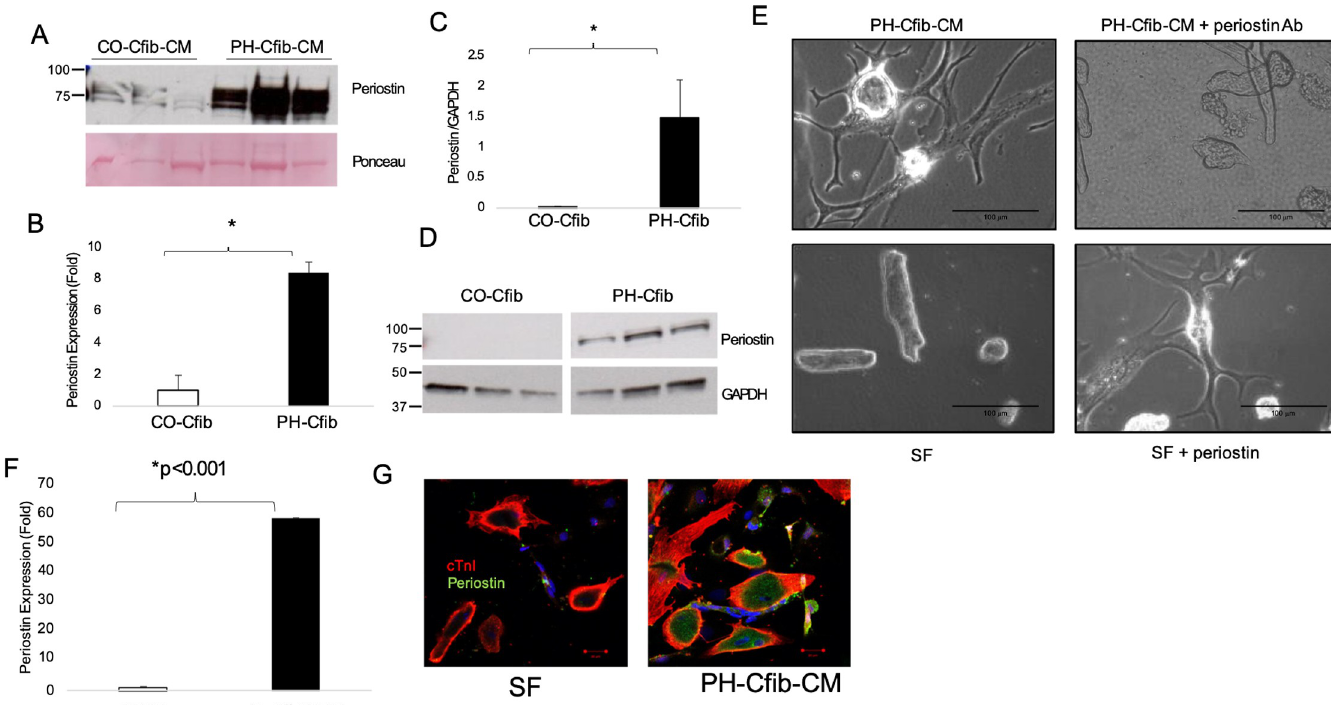
Fig 7. Periostin drives adult myocyte dedifferentiation. A) Periostin is significantly expressed in the PH-CM compared to CO-CM. B) Periostin RNA and C,D) protein expression are significantly higher in PH Cfib compared to CO. E) Immunodepletion of periostin from the PH-CM attenuates dedifferentiation, while addition of recombinant periostin to SF media stimulates dedifferentiation. F) Periostin expression is robustly upregulated in the dedifferentiated myocytes compared to freshly isolated ARVM. G) Periostin protein expression is upregulated in dedifferentiated cells compared to SF-treated. Periostin RNA and protein expression were assessed by qRT-PCR and immunoblotting, respectively. Experiments were performed in 3 PH and 2 CO calves in biological triplicate. � p < 0.05 by student’s t-test.